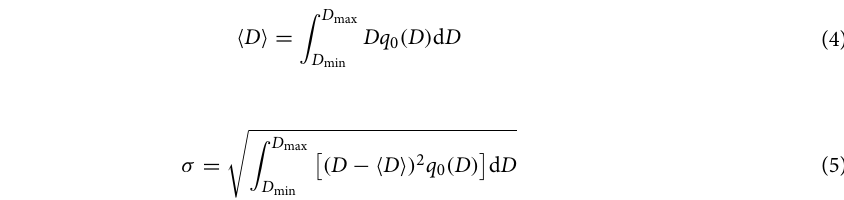
Figure 7. Number distribution density ( q 0 ) of the size of the IONFs ( D hydrodynamic diameter ( D